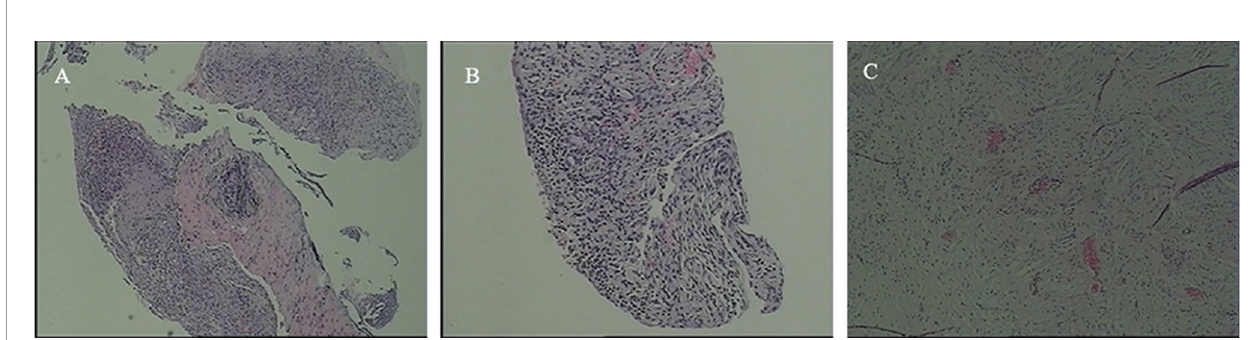
FIGURE 2 | CT-guided biopsy of the right renal lesion in August 24, 2020 and in September 4, 2020, respectively, The pathologic result revealed respectively that (A) there was fi brous tissue with extensive in fl ammatory cell in fi ltration and (B) there was lymphocytic in fi ltration in the stroma, but no tumor was observed. (C) After laparoscopic radical nephrectomy of the right kidney under general anesthesia, postoperative pathological analysis revealed that kidney tissue and perirenal adipose sac presented chronic suppurative in fl ammation and abscess formation, but still no tumor was